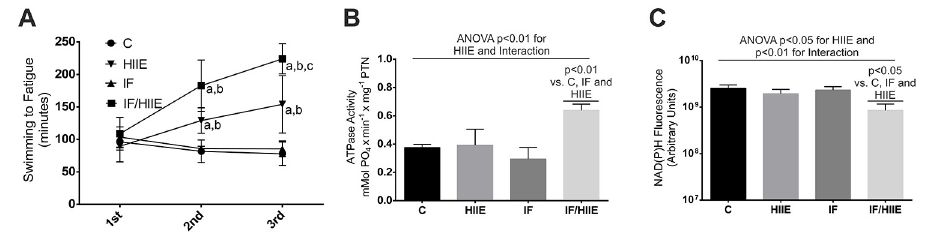
Fig 5. PT and energy production. (A) PT. The physical endurance was measured using swim until fatigue test (under a 12% bw overload). The tests were applied on three separate occasions: (1st) one day before day 0, (2nd) at day 28, and (3rd) at day 56. p < 0.05; a vs. control, b vs. HIIE, and c vs. IF. (B) FoF1 ATP synthase activity was estimated through the ATPase activity of the enzyme. (C) NAD(P)H autofluorescence was measured directly in fresh muscle homogenates (gastrocnemius). The excitation and emission wavelengths were 340 nm and 450 nm, respectively. Each bar represents the mean ± SD; A-C) n = 6. Individual effects (IF and HIIE) and the effect of their interaction were verified by two-way ANOVA and multiple comparisons; p values were